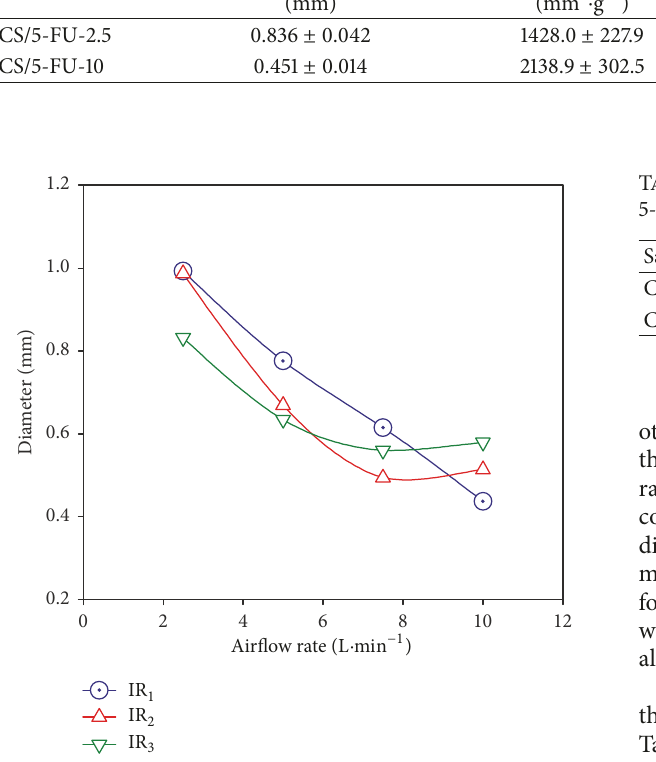
Figure 4: Diameter of the microspheres prepared at different injection flow rates.